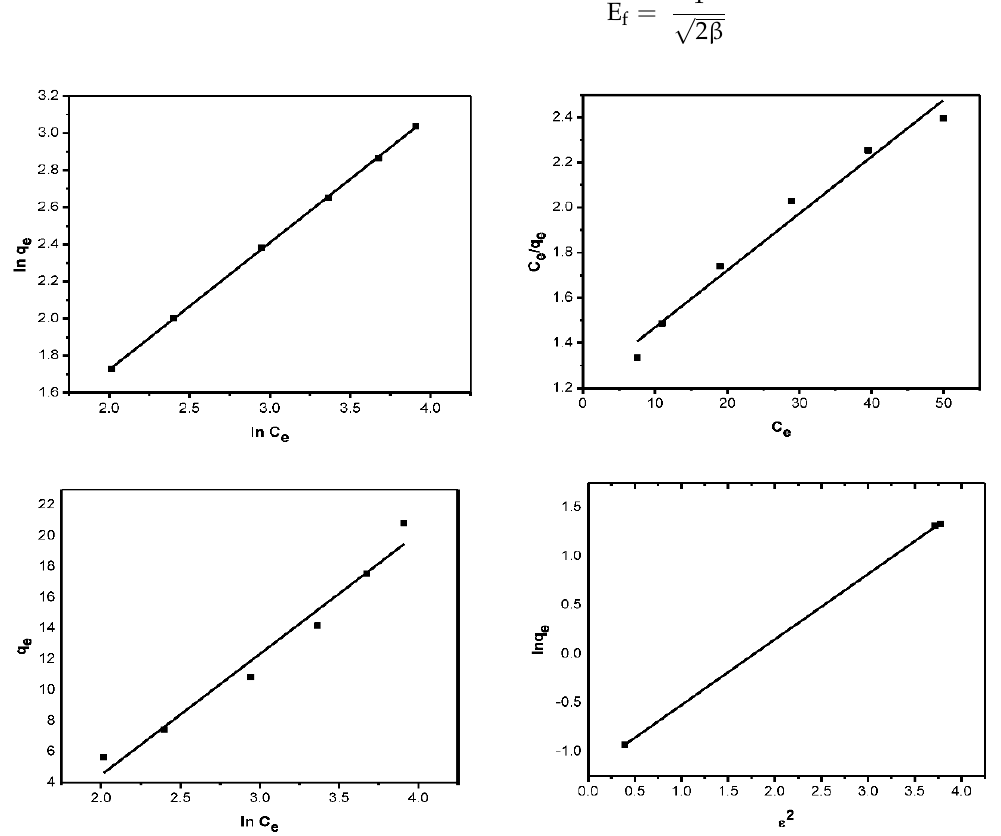
Figure 10. Adsorption isotherm models: ( a ) Langmuir; ( b ) Freundlich; ( c ) Temkin; and ( d ) D ‐ R.